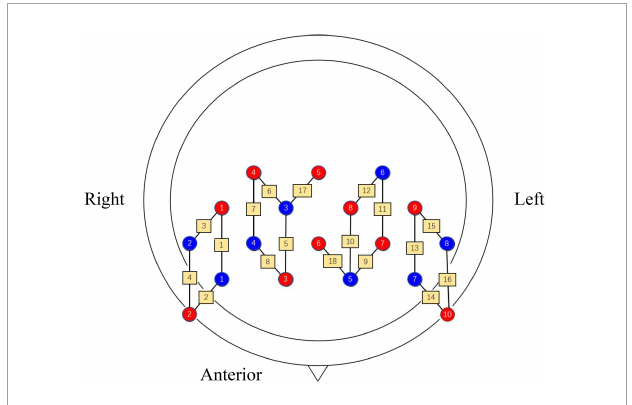
FIGURE2 Arrangement of each channel, where red indicates the light source, blue indicates the receiver source and yellow pathways indicate the